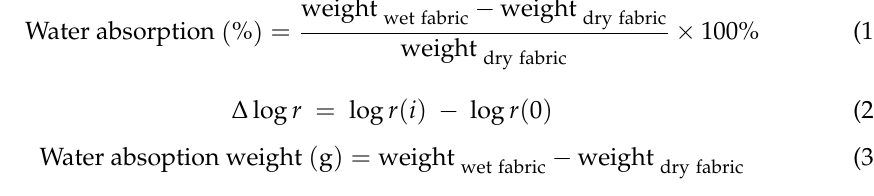
Figure 3. The contact angle of conductive knitted fabrics (( a ) 120.2° for untreated fabric and ( b ) 99.4° for treated fabric).